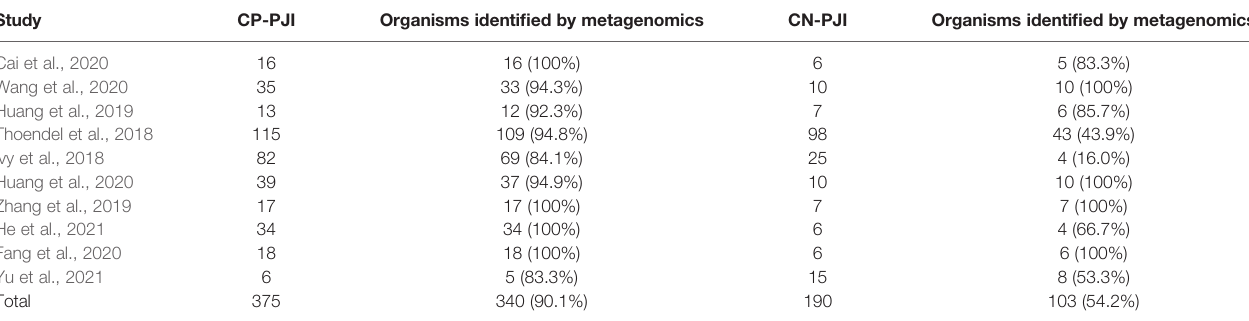
TABLE 2 | Performance of mNGS versus culture.